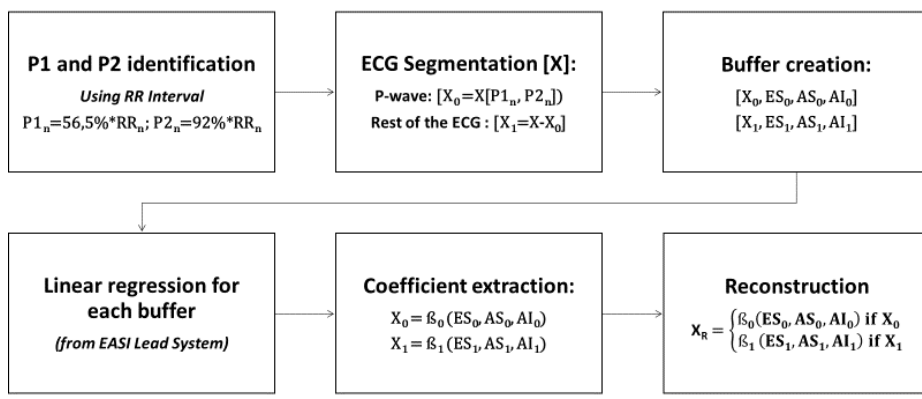
Figure 4. Block diagram of the P wave segmentation algorithm to reconstruct the ECG